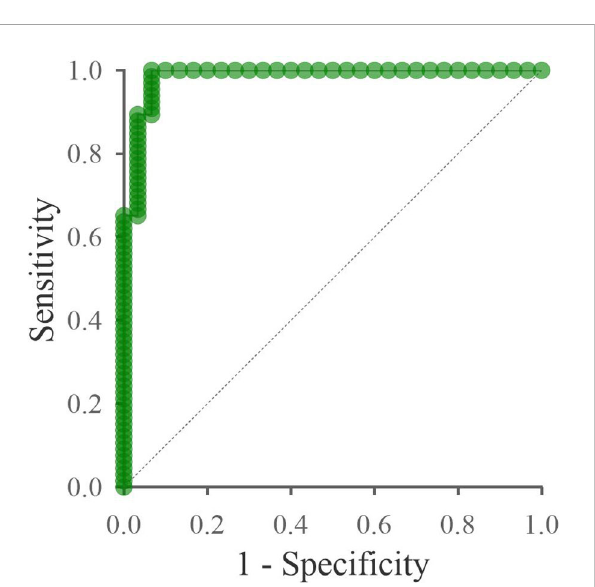
FIGURE 6 Comparison of relative expression of tested miRNAs. The Fold Change values are plotted on a logarithmic scale. miR-320a-3p and miR-7704 show statistically signi fi cant upregulation. miR-26a-5p shows statistically signi fi cant downregulation. miR-4286 and miR- 4454 are not statistically signi fi cant. Horizontal lines represent median values, and error bars show a 95% con fi dence interval. The abbreviation "ns" indicates not a signi fi cant difference, and *** indicates a p-value